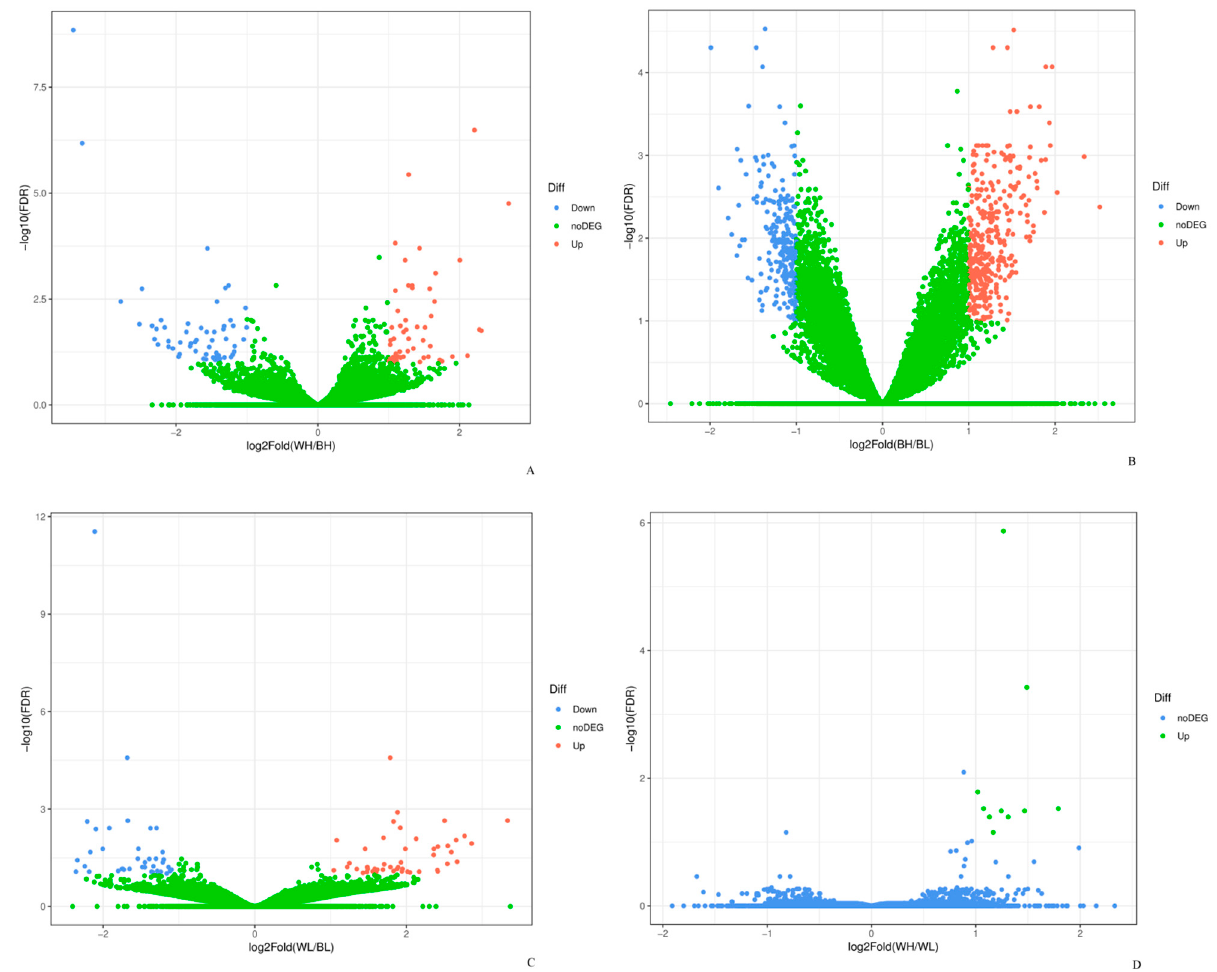
Figure 1. Statistic of differentially expressed genes (DEGs).